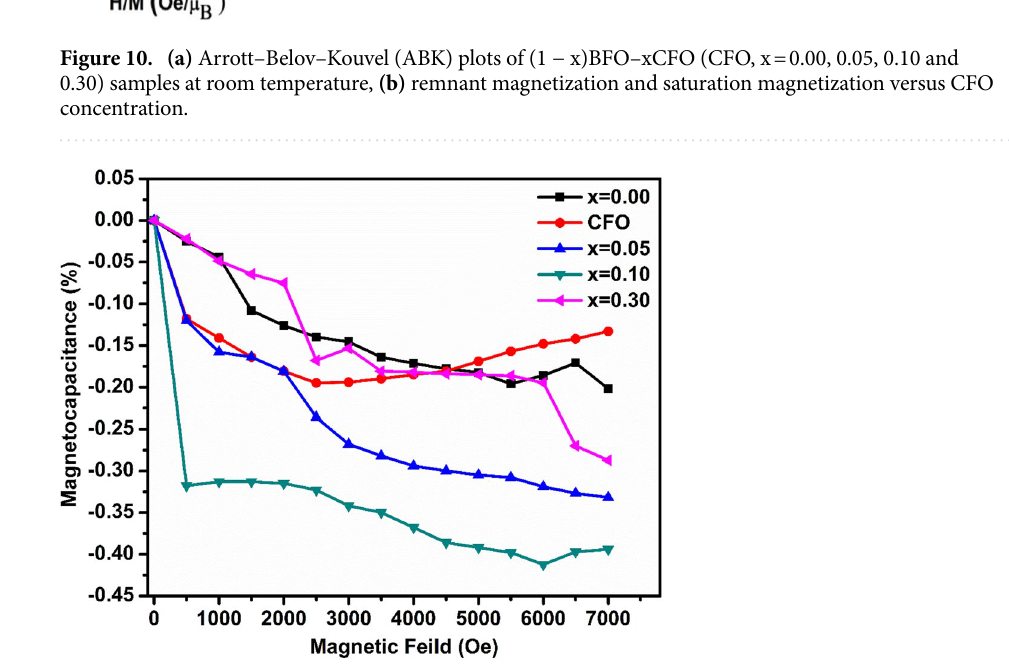
Figure 11. Magneto-capacitance versus magnetic field measurement of (1 − x)BFO–xCFO (CFO, x = 0.00, 0.05, 0.10 and 0.30) samples at room